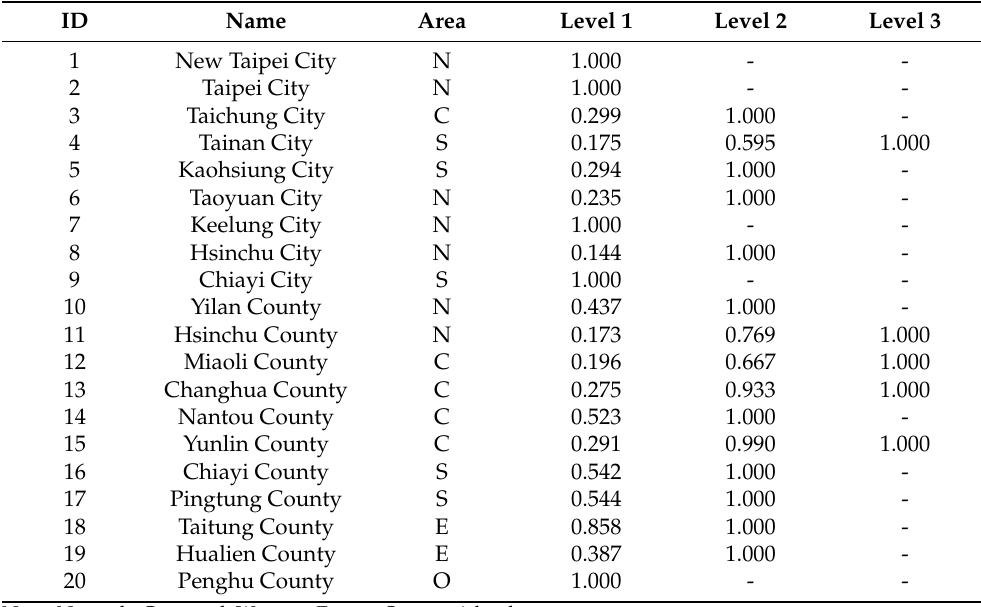
Table 4. Multi-level efficiency frontiers of electricity for production of counties and cities in Taiwan.